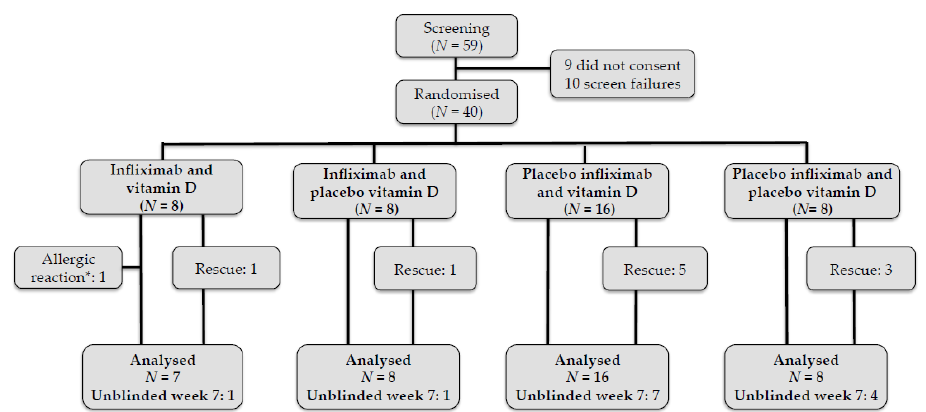
Figure 1. Patient flow during the 7-week study period. Patients who underwent rescue treatment were included in the final analyses. * One patient had an allergic reaction to infliximab at the second infusion and was excluded. Infusion treatment in non-responding patients with on-going endoscopic inflammation was unblinded at week 7, and infliximab treatment was